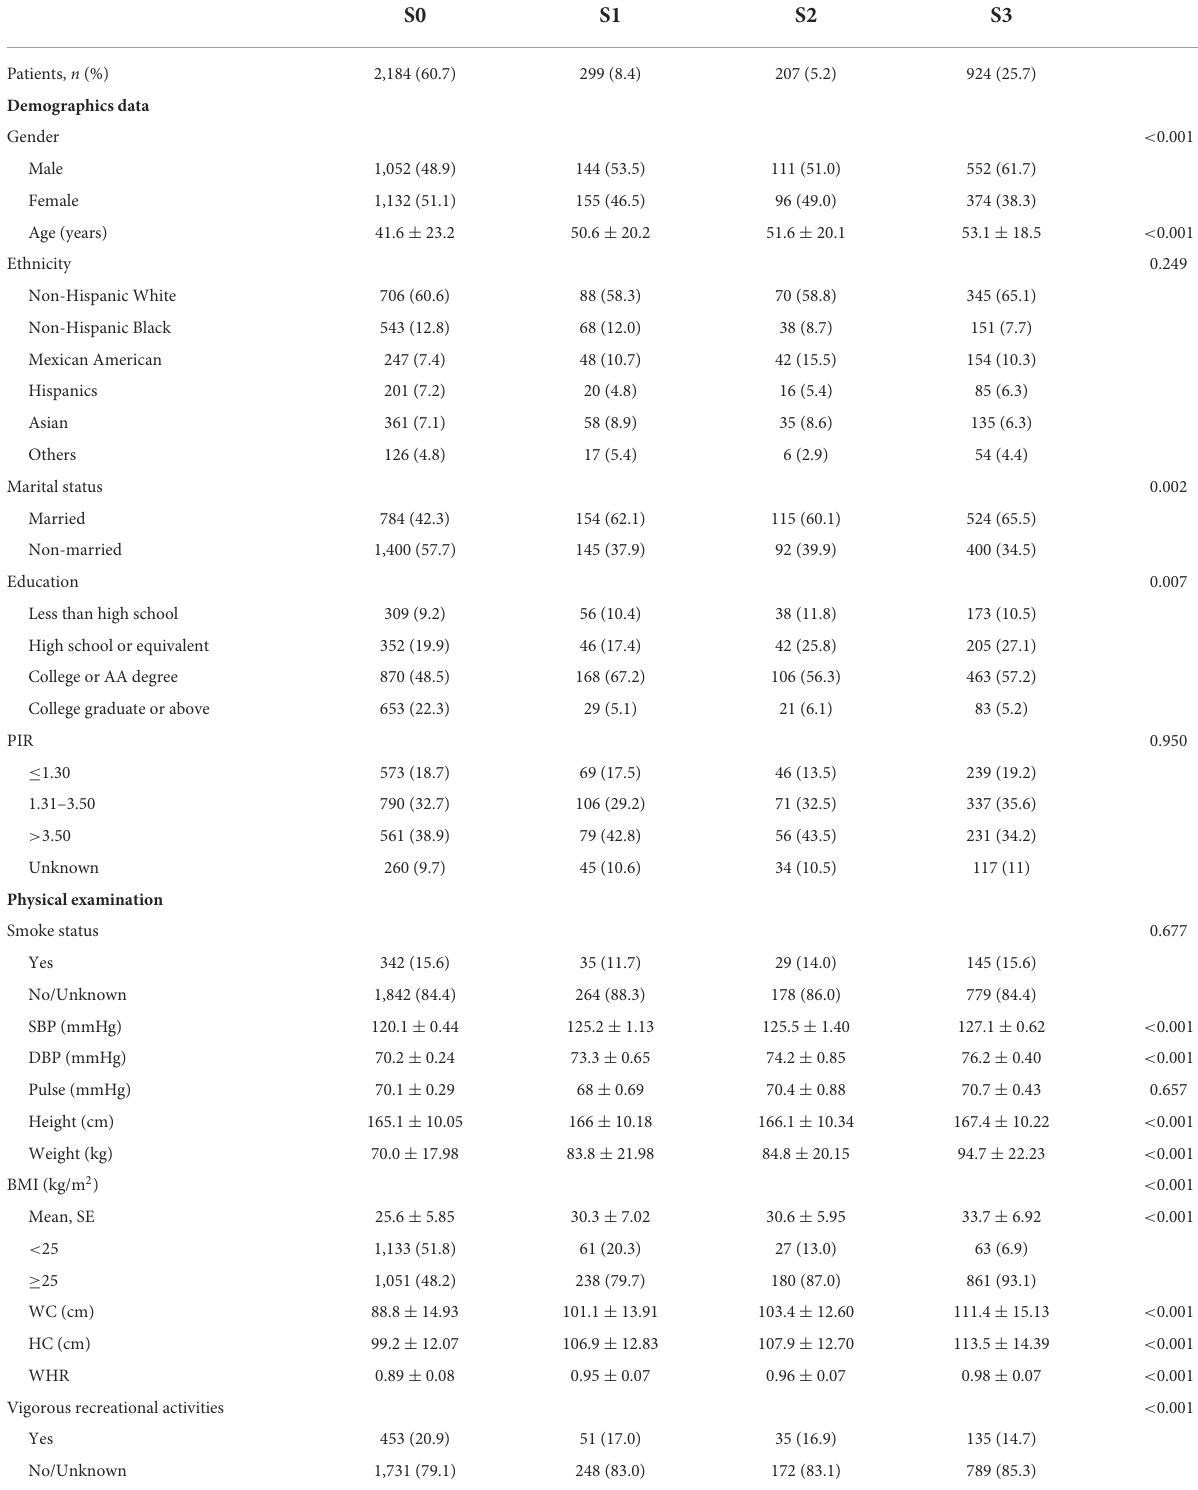
TABLE 1 Characteristics of the study population according to CAP values *